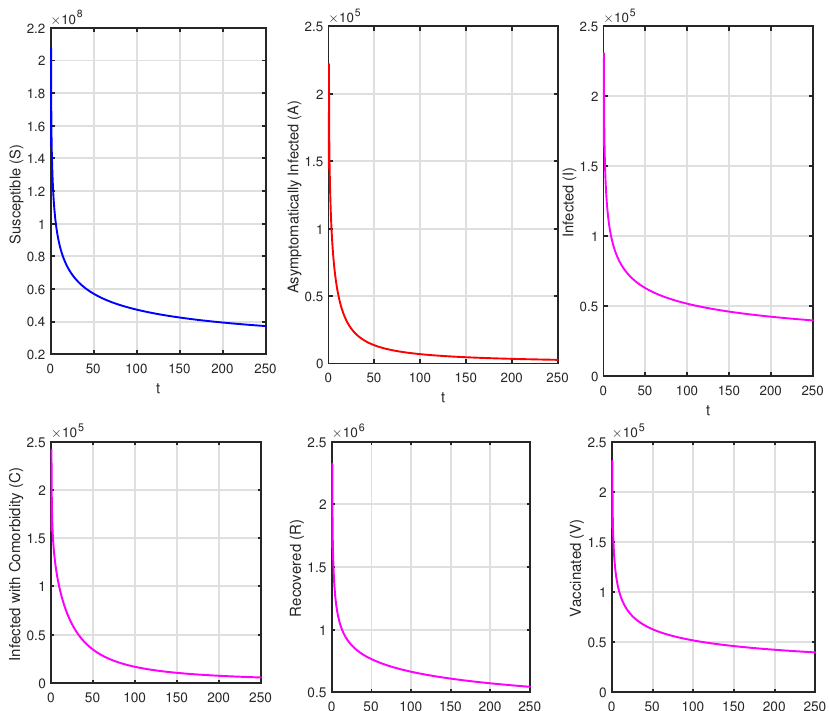
Figure 11. Time series of state variables when combined control strategy is implemented T f = 250, ε =